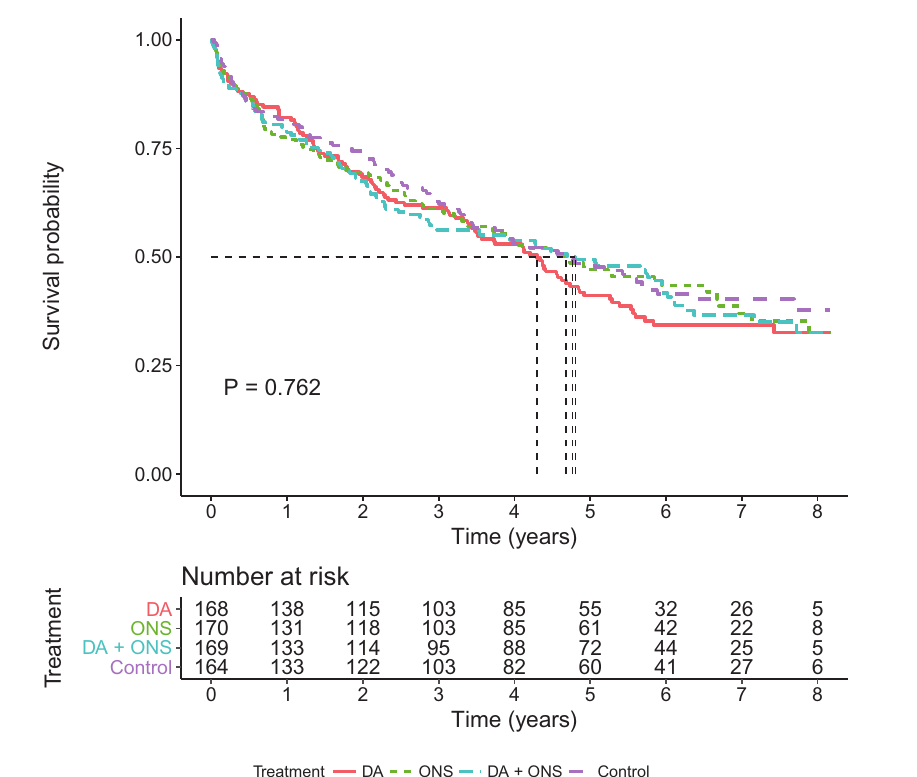
Figure 2. Kaplan – Meier survival curves for participants in the four intervention groups ( n ¼ 671). Log-rank test for any difference between groups ( p ¼ 0.762). DA: dietary advice; ONS: oral nutritional